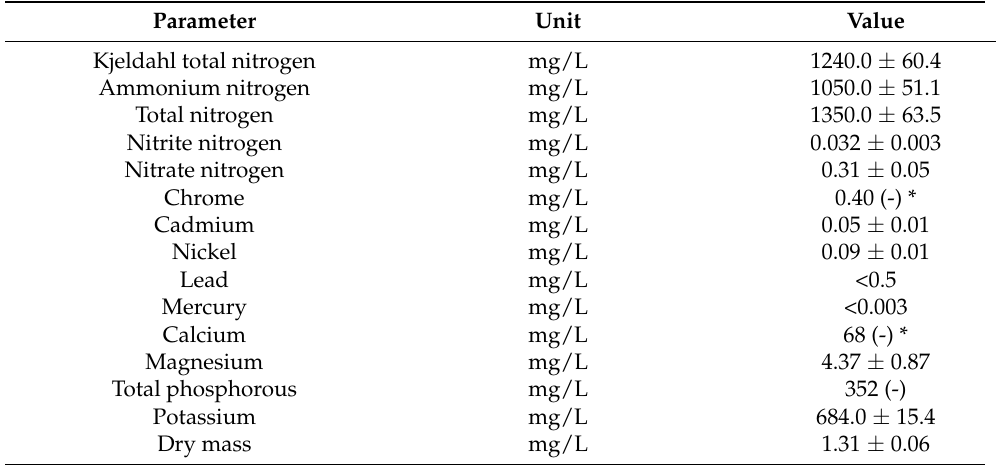
Table 3. Chemical composition of liquid pig